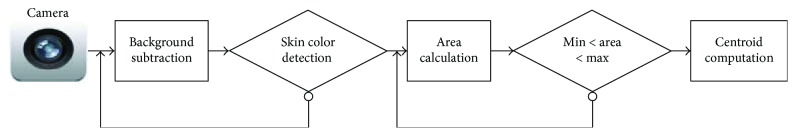
Extraction of hand coordinates.